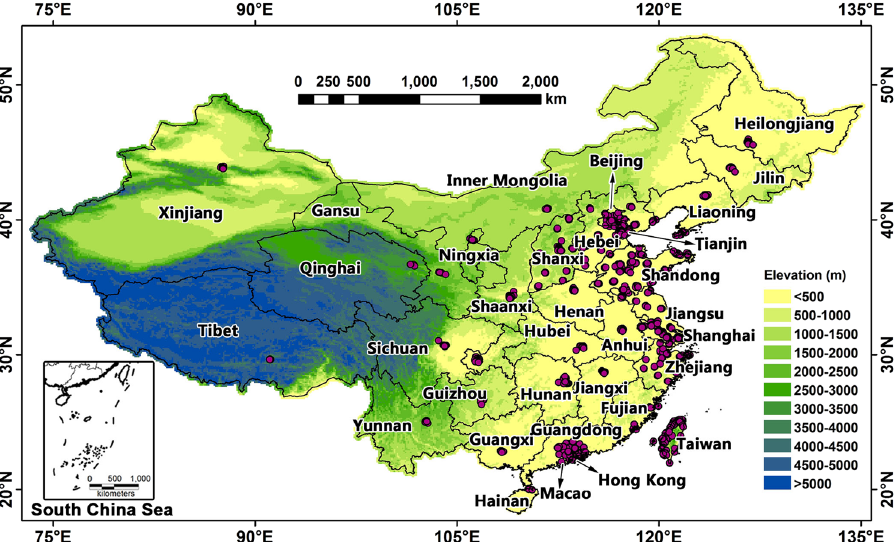
Figure 1. Spatial distribution of PM 2.5 monitoring sites included this study. This map was generated using ArcGIS 9.3 (http://www.esri.com/software/arcgis) 26 based on the geo-location information of the PM 2.5 ground- based monitoring sites and elevation data. The elevation data were obtained from the Global Multi-resolution Terrain Elevation Data 2010 data product (https://lta.cr.usgs.gov/GMTED2010) 27